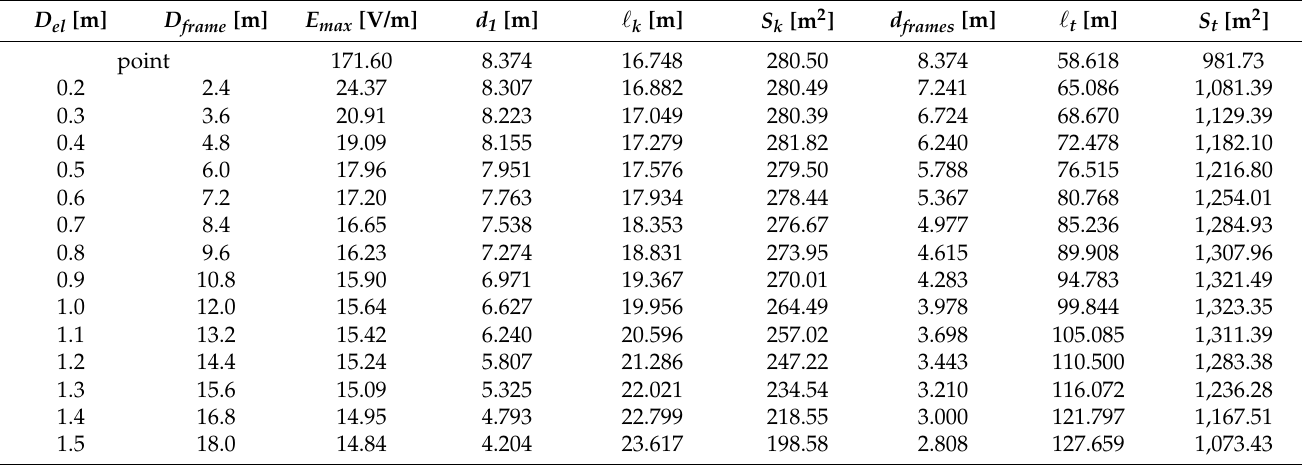
Table 11. Simulation results with method “C”, of linear current source, for a linear frame of 13 electrodes, for the area of Stachtoroi, Attica ( ρ S = ∞ , without dam, L = 2.13 m, ρ w = 0.25 Ω ·